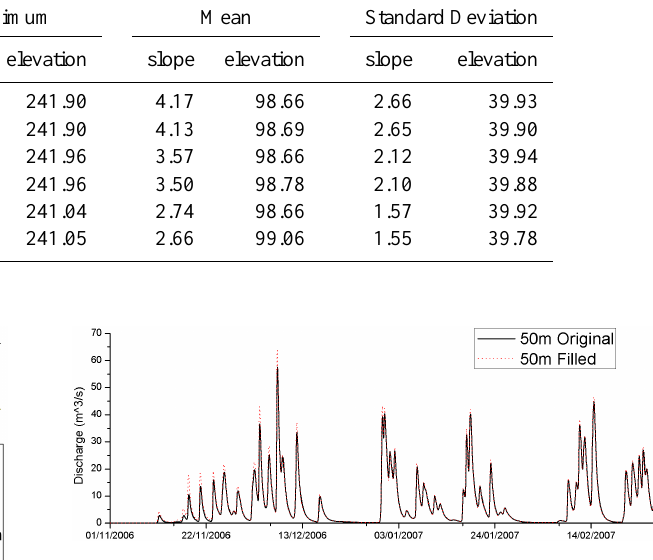
Fig. 8. Surface flow simulations for the 50m resolution DEM in MIKE SHE. Table 3. Statistics of the depression using DEM differences (unit: